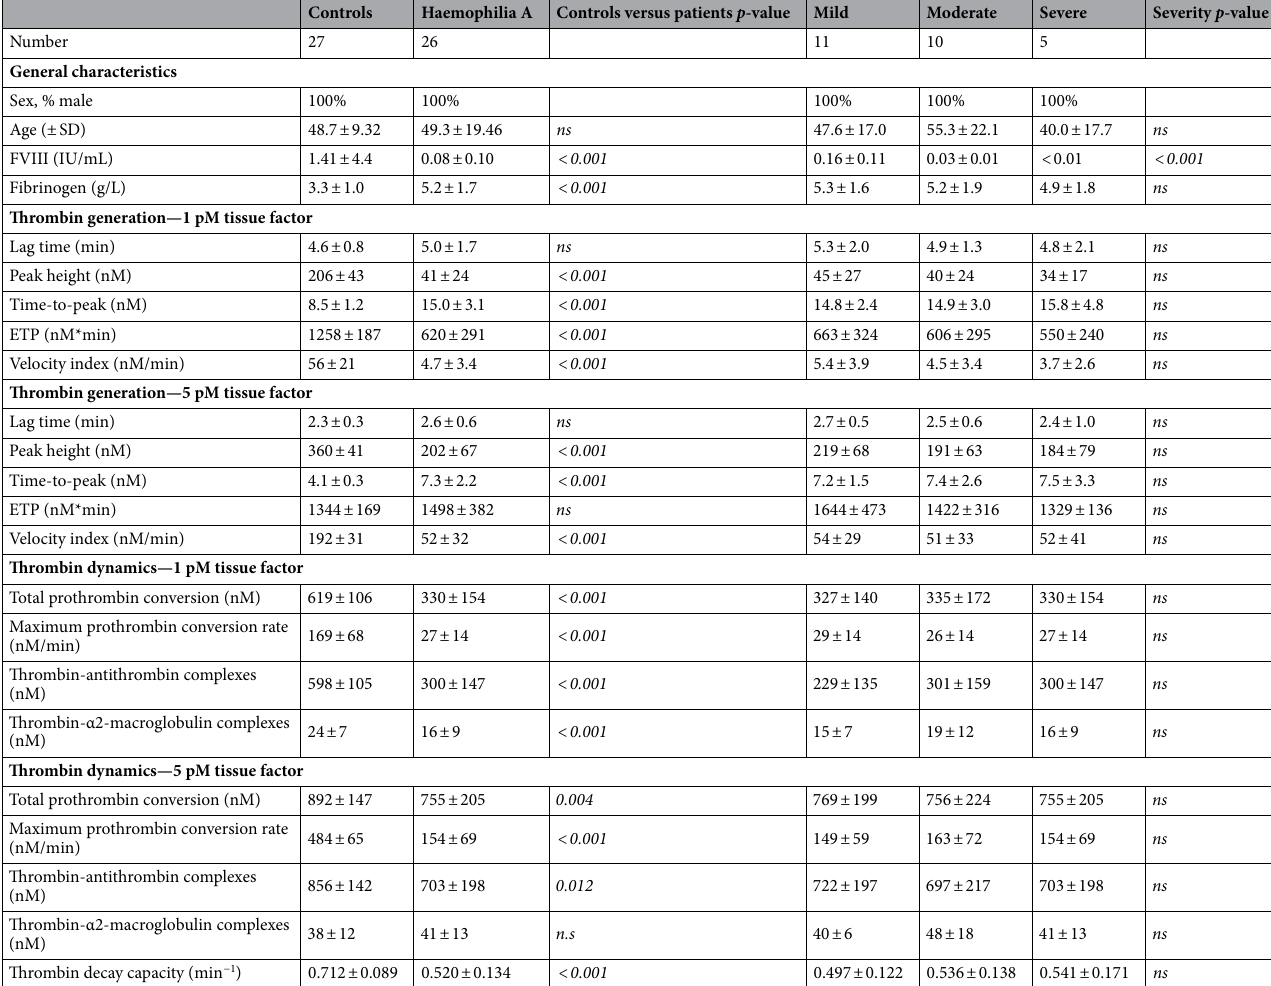
Table 1. General characteristics and thrombin generation and thrombin dynamics data of controls and haemophilia A patients. Data is shown as mean ± standard deviation for the control and combined patient group. Statistical differences between the control and combined patient group are indicated as a p -value below 0.05 according to the Mann–Whitney test. Data is shown as mean ± standard deviation for subgroups of the patient group. Statistical differences between the subgroups are indicated as a p -value below 0.05 according to the Kruskal–Wallis